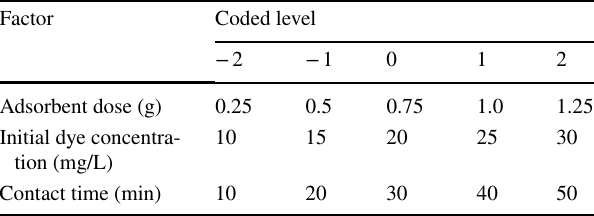
Table 1 Experimental range and levels of independent variables in adsorption Factor Coded level Adsorbent dose (g)